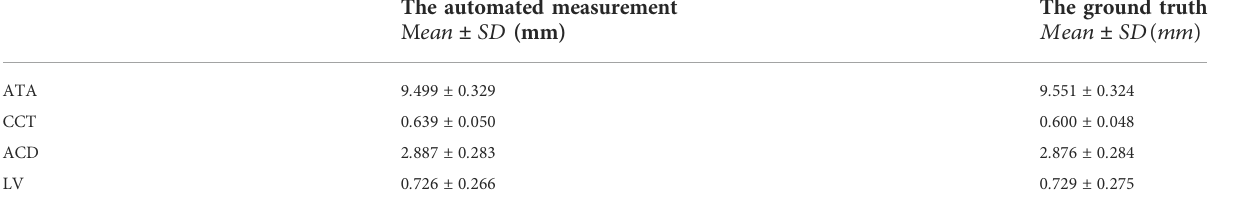
TABLE 2 The outcomes of the automated measurement and ground truth.